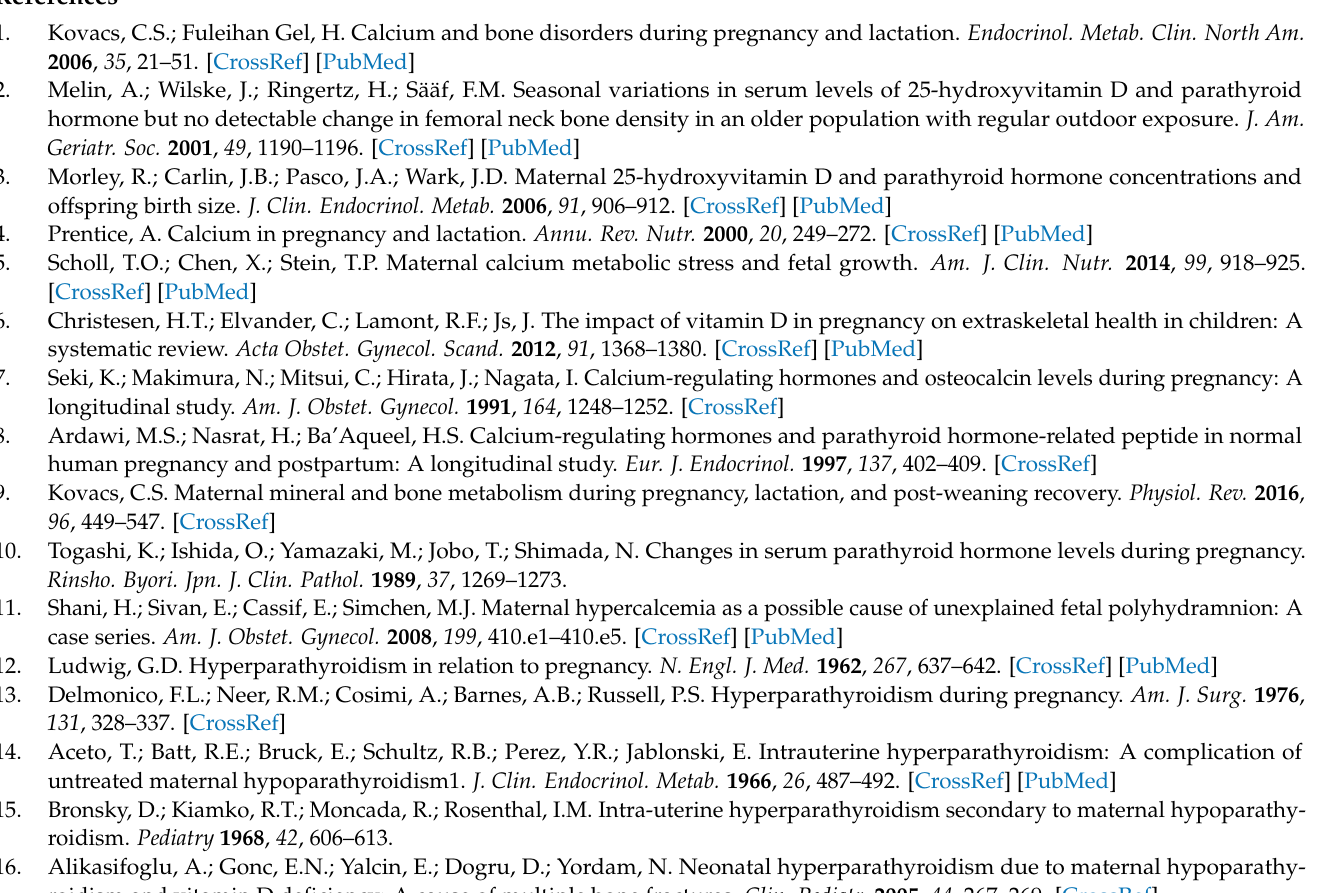
variable and 25(OH)D as the independent variable adjusted for regression variables in the first trimester, Table S2: Hockey-stick regression models with PTH (ng/mL) as the dependent variable and 25(OH)D as the independent variable adjusted for regression variables in the third